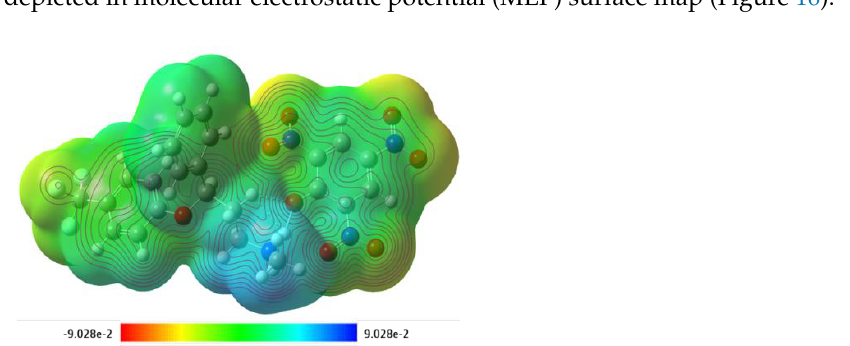
Figure 15. SASA analysis for unbound serotonin (black), [(FXN)(PA)] – serotonin (brown), and FXN – serotonin (green) during the 100 ns MD simulation.